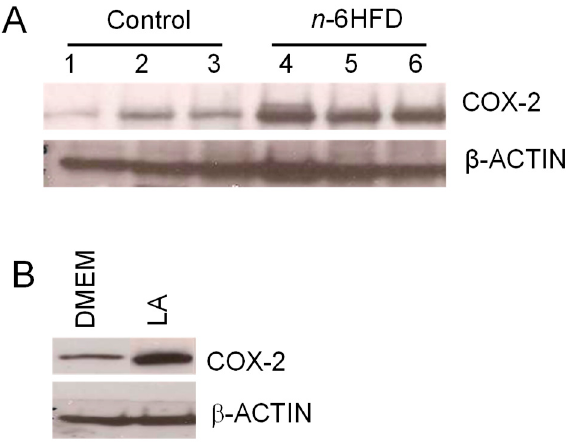
Figure 3. An n -6HFD induces Ptsg-2 (prostaglandin-endoperoxide synthase-2) CpG demethylation in mouse colonic mucosa. ( A ) The bars represent means ± SEM of quantitation (fold change of control) of Cox-2 mRNA corrected for Gapdh mRNA as an internal standard. Means ± SEM with an asterisk differ ( p < 0.05). ( B ) PCR bands amplified from bisulfonated genomic DNA obtained from proximal colonic mucosa with mouse Ptsg-2 - and β -actin -methylation (M)-specific primers. MC = methylation control. ( C ) Quantitation (fold-change/control) of Ptsg-2 promoter methylation status with control ( n = 5) and n -6HFD ( n = 6).